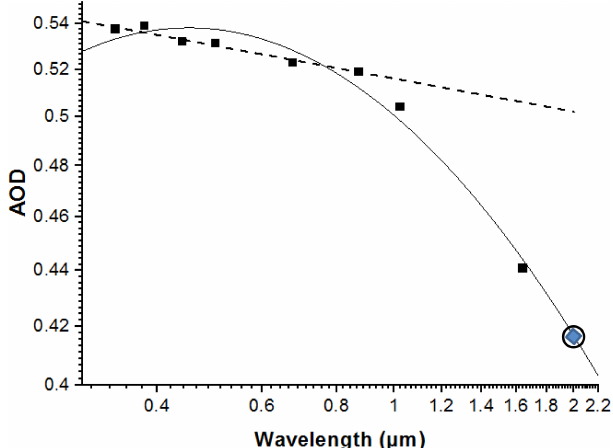
Figure 2. Aerosol optical depth as a function of wavelength in a log–log scale for 11 June 2013 at 11:12UTC. Solid line indicates the 2nd-order fit over the rage 340–1640nm, whereas the dashed line indicates the 1st-order fit over the range 440–870nm, corre- sponding to the Ångström formula (Ångström, 1961). The extrapo- lated value of AOD at the 2µm wavelength using the 2nd-order fit is indicated with a circle.